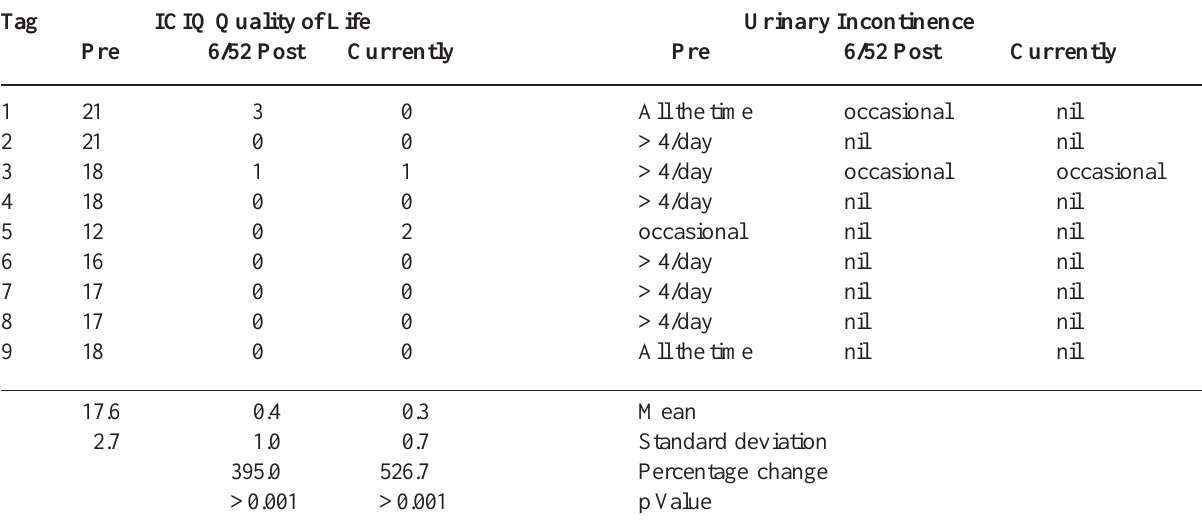
Table 2 – Patient symptom measures pre- and postoperation.